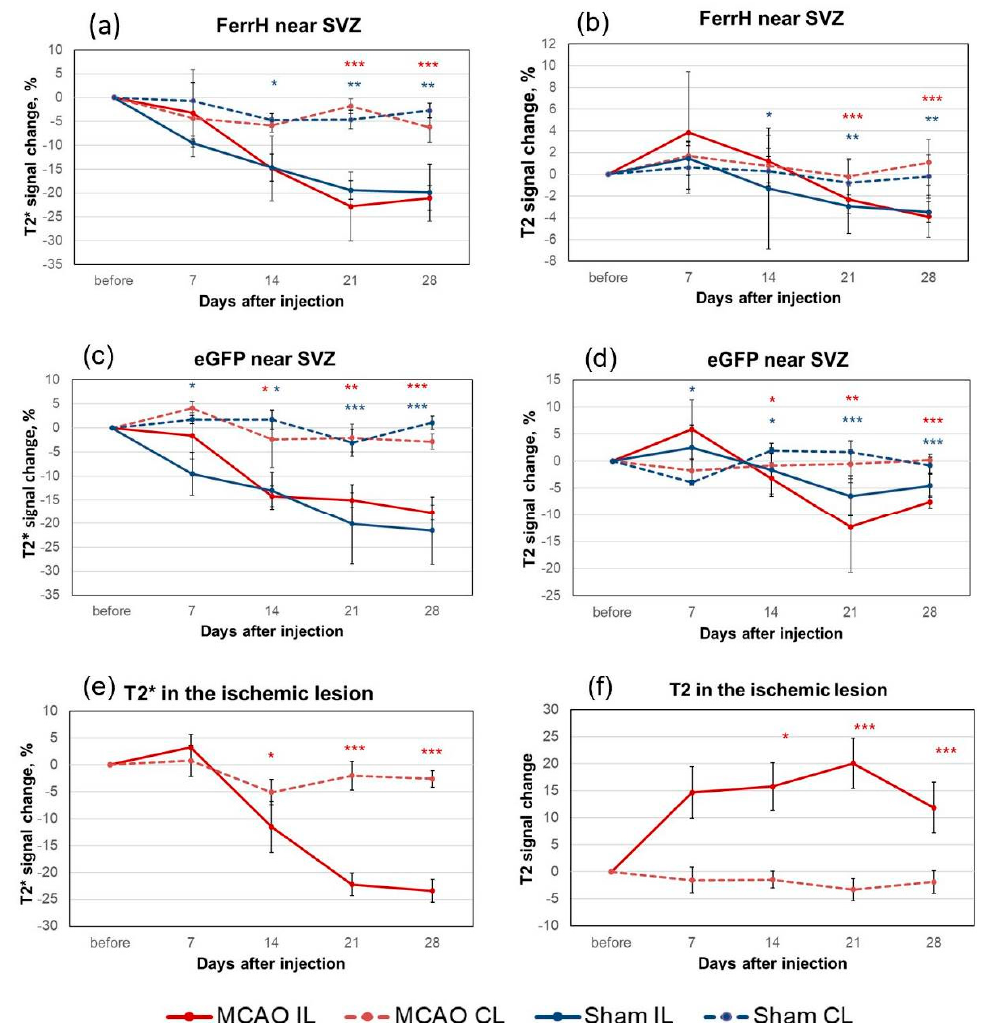
Figure 3. Quantification of the MRI signal in the zones of hypointensity on T2*- and T2-weighted images on di ff erent days after injection of AAV-pDCX-FerrH and AAV-pDCX-eGFP. ( a , b ) Percentage change of signal hypointensity near the SVZ on T2*- ( a ) and T2-weighted ( b ) images before and after AAV-pDCX-FerrH injection. Numbers are shown relative to the baseline (before MCAO or sham operation). ( c , d ) Percentage change of signal hypointensity near the SVZ on T2*- ( c ) and T2-weighted ( d ) images before and after AAV-pDCX-eGFP injection. ( e , f ) Percentage change of signal hypointensity areas in the ischemic lesion (FerrH and eGFP groups combined). Statistically significant di ff erences in MRI signal change between ipsilateral and contralateral hemispheres were marked with stars (*), according to ANOVA after LSD’s correction for multiple comparisons: * p < 0.05; ** p < 0.01; *** p < 0.001. Abbreviations: MCAO, middle-cerebral-artery-occlusion; AAV, adeno-associated viral backbone; pDCX, doublecortin promoter; FerrH, ferritin heavy chain; eGFP, enhanced green fluorescent protein; SVZ, subventricular zone; IL, ipsilateral; CL, contralateral.